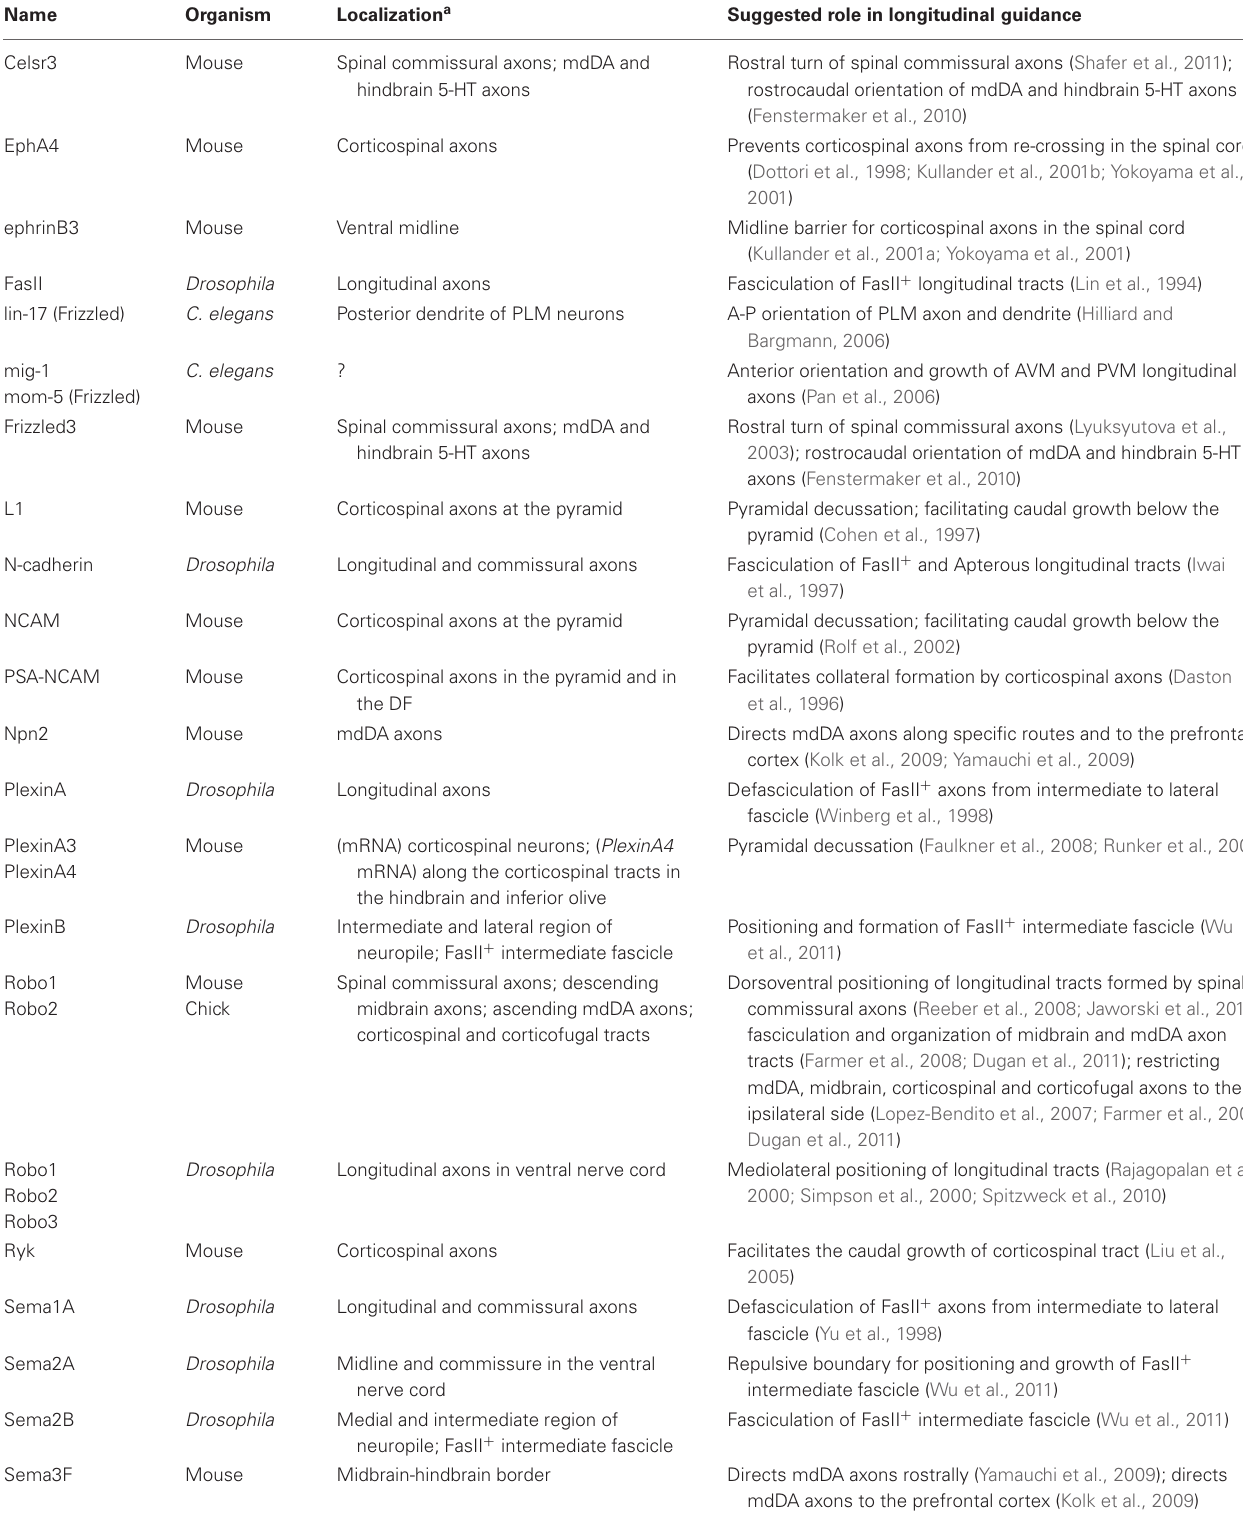
Table 1 | Selected molecules associated with the pathfinding of longitudinally projecting